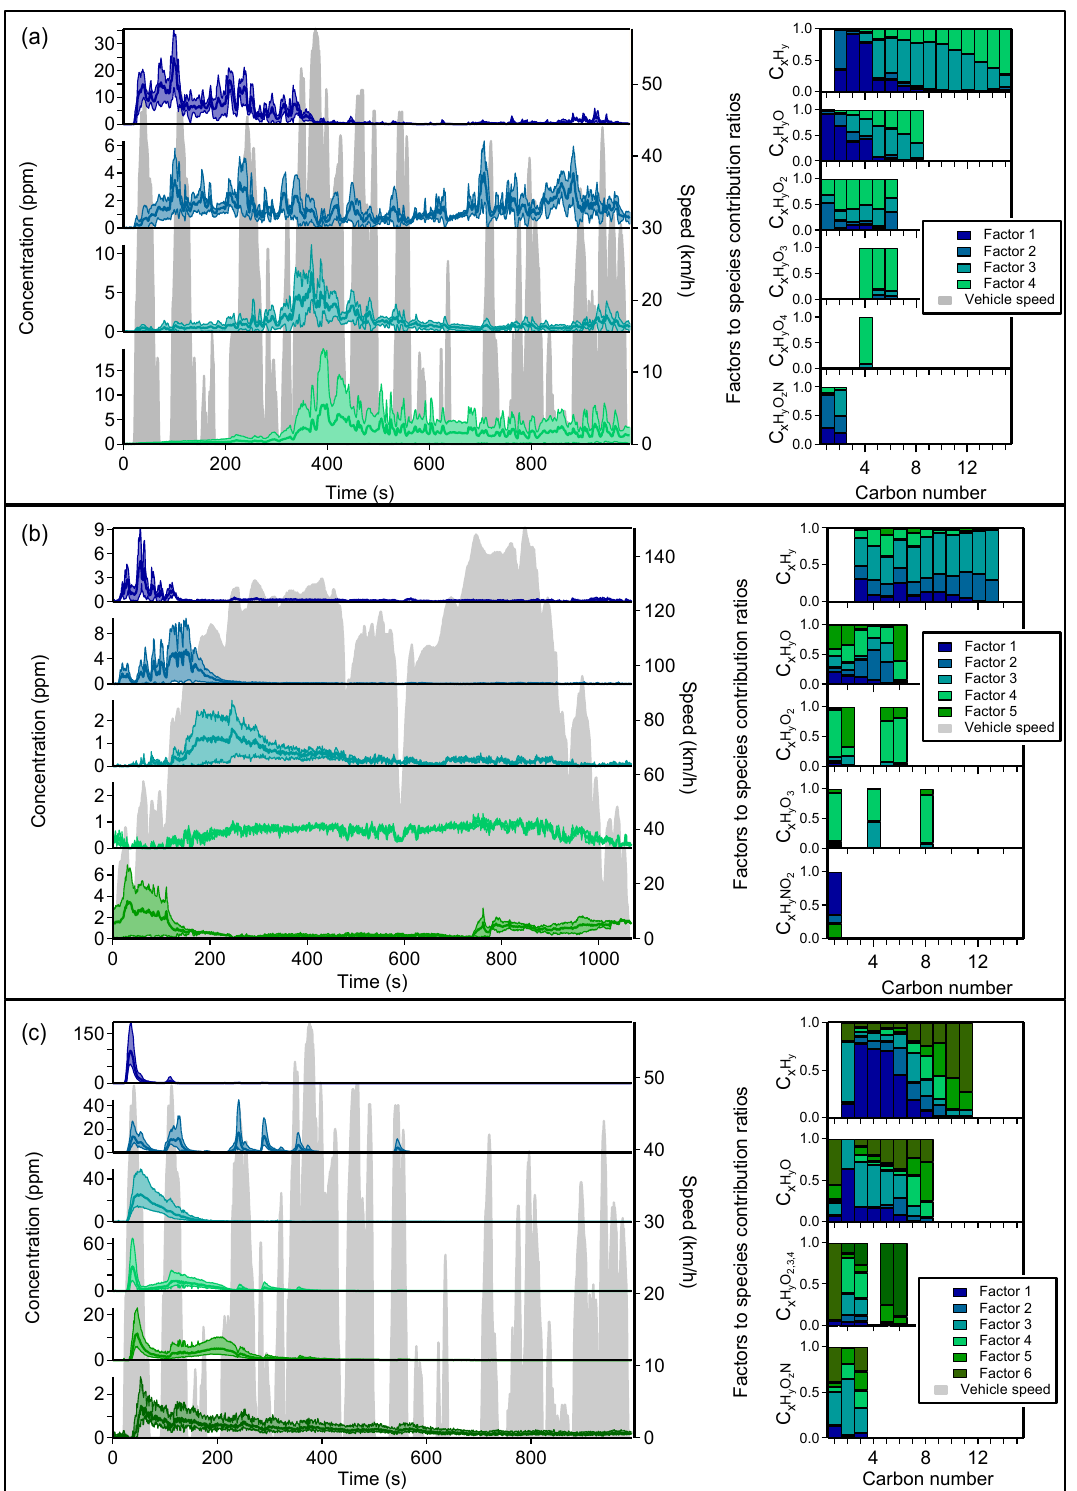
Figure 2. PMF factor temporal variations and contribution ratios for a typical ( a ) diesel CU cycle, ( b ) diesel MW cycle, and ( c ) GDI CU cycle. Time series of the factors are averaged over ( a ) 4 cycles, ( b ) 2 cycles, and ( c ) 6 cycles. For each factor, the bold line represents the averaged concentration corrected from the dilution, and the colored zone represents the associated standard deviation. The gray zone represents the speed variations during CU and MW cycles. Factors to species contribution ratios are classified by carbon, oxygen, and nitrogen